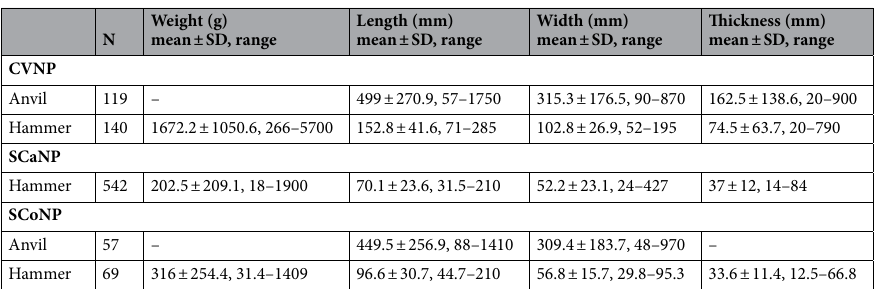
Weight (g) N mean ± SD, range